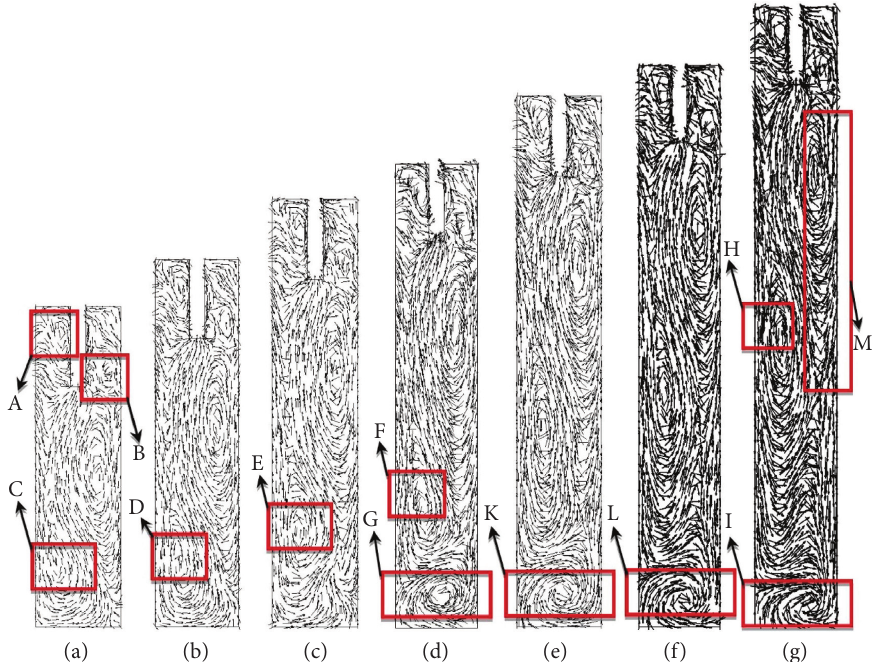
Figure 14: Separator flow field at different cylinder lengths. (a) l l 2 � 110mm. (g) l 2 �